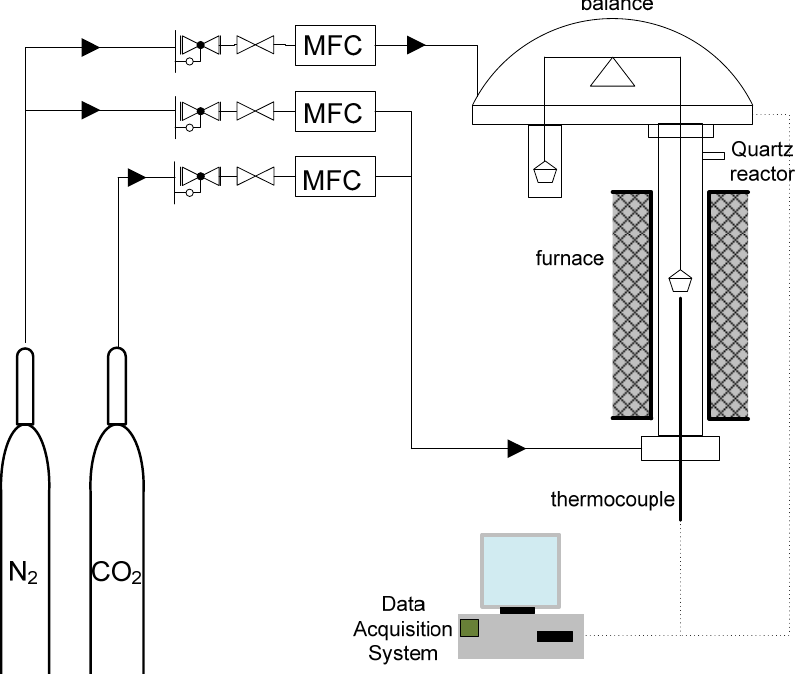
Figure 1. Schematic diagram of the experimental